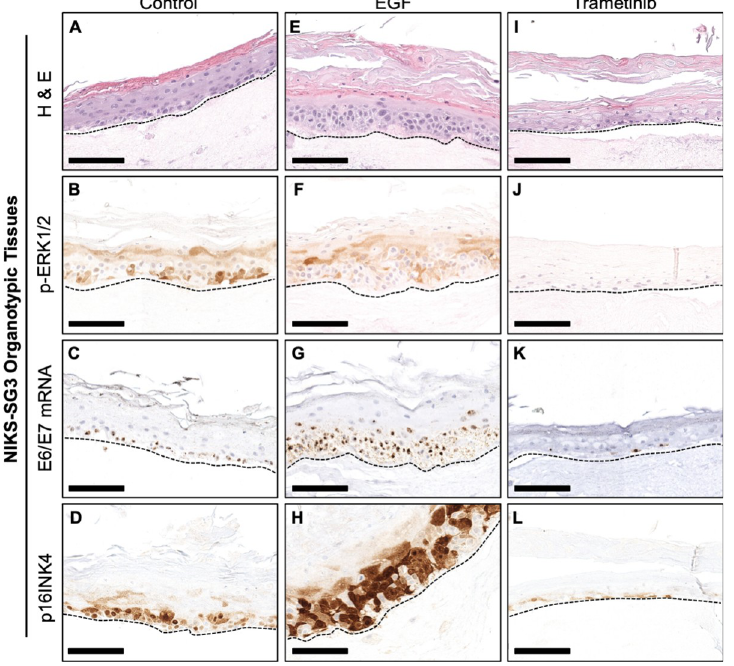
Fig 7. EGFR and MEK signaling regulates HPV oncogene expression in 3D-organotypic epithelial tissue models. Representative images of organotypic epithelial tissues from NIKS-SG3 cells grown at the air-liquid interface for 8 days prior to treatment with 10 ng/ml EGF or 10 nM trametinib every second day. FFPE tissues harvested on day 14 were sectioned and stained: (A, E, I) H&E; (B, F, J) IHC for p-ERK1/2; (C, G, K) RNA ISH (brown); (D, H, L) IHC for p16. Broken lines underscore the basal cell